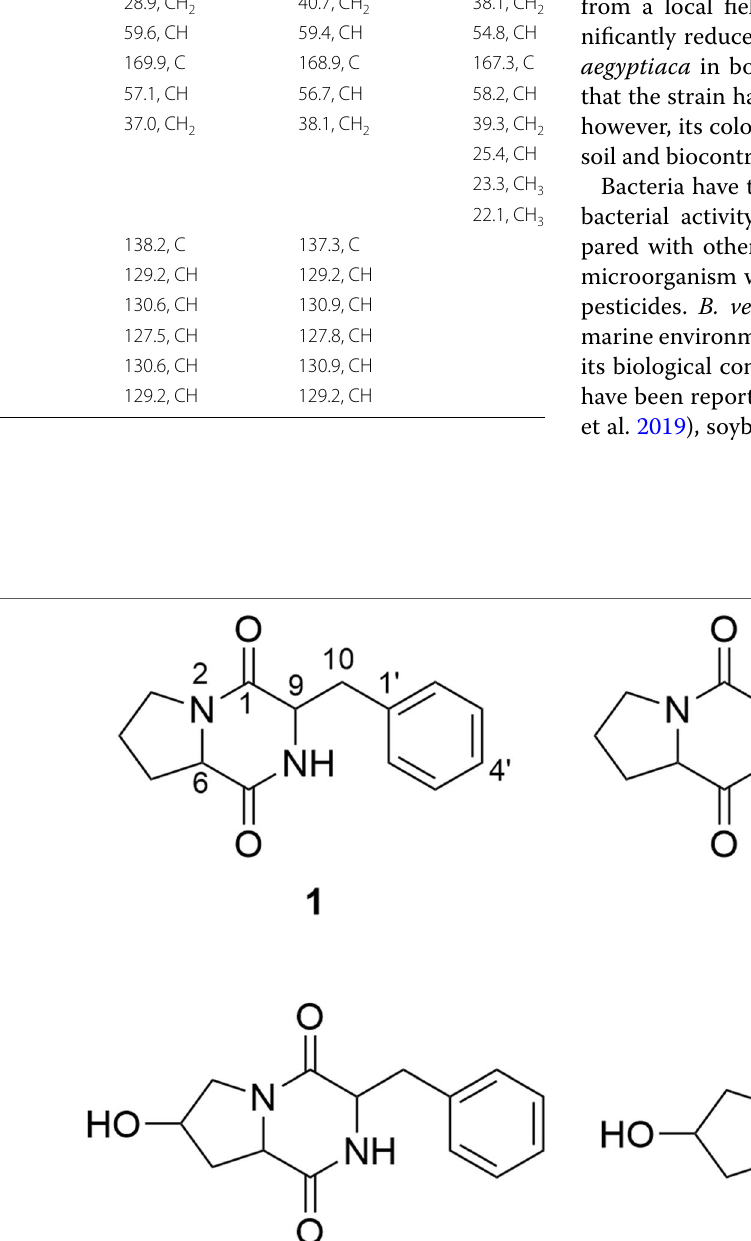
, 125 MHz) of compounds 1 , 6